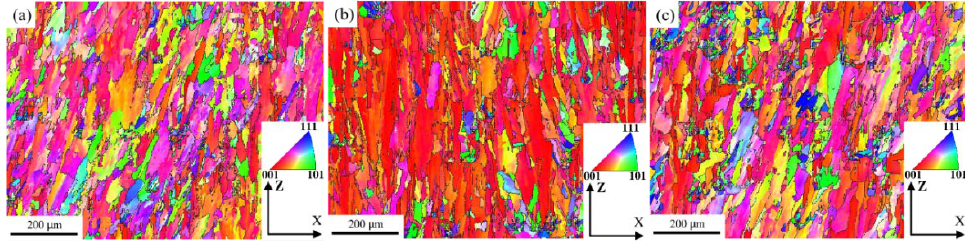
Figure 5. Grain orientation maps of K418 alloy at different scanning speeds: ( a ) 800 mm/s; ( b ) 1200 mm/s; ( c ) 1600 mm/s.